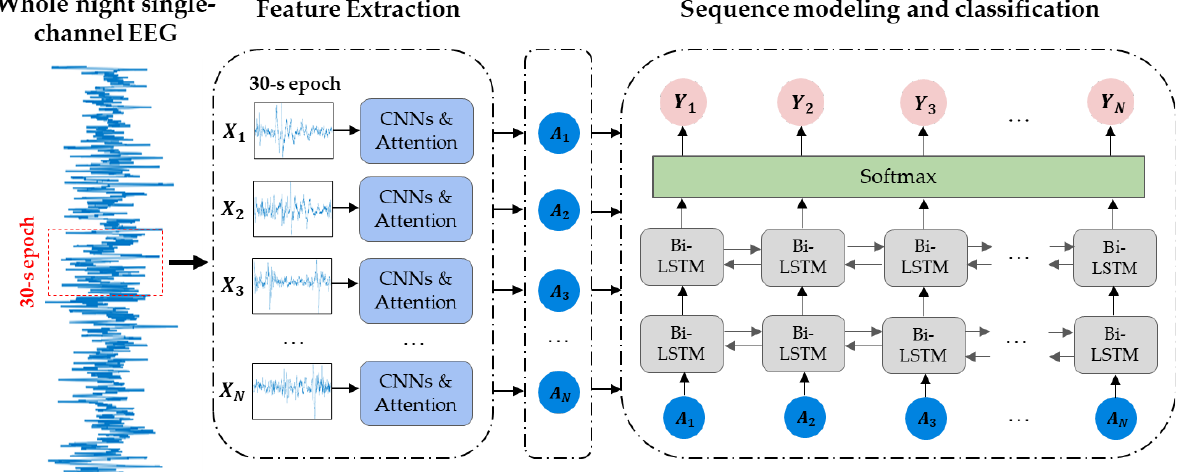
Figure 1. General architecture of CattSleepNet.